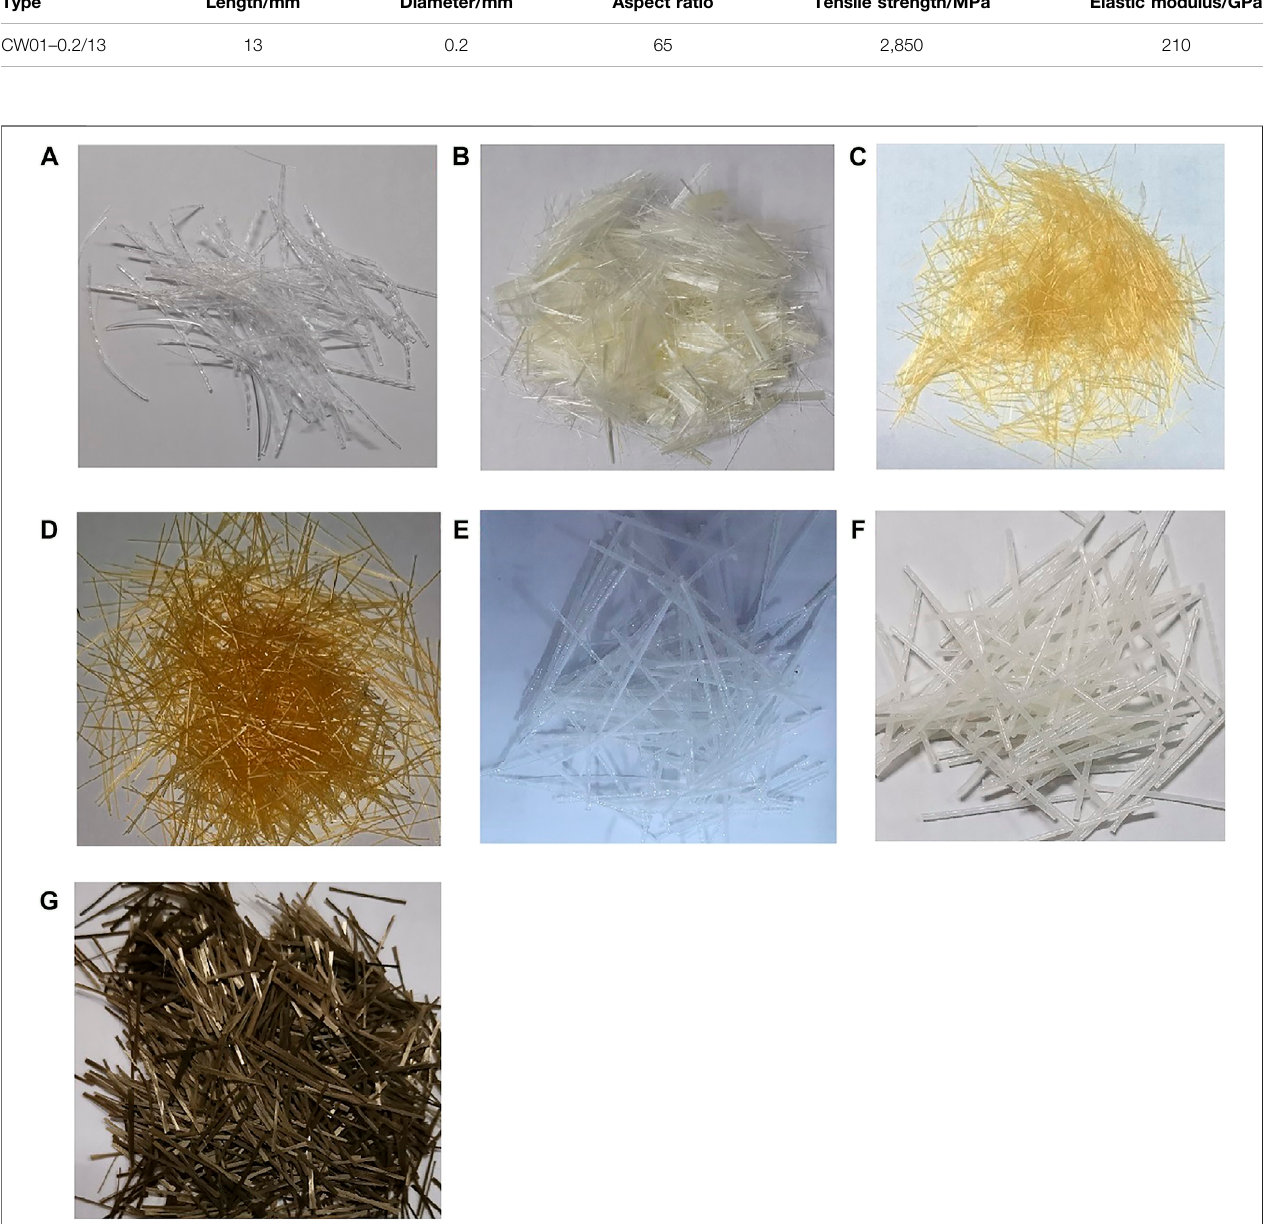
FIGURE1| Photosofnon-metallic fi bers. (A) PP-40-0.6, (B) PVA-12-0.04, (C) PVA-8-0.2, (D) PVA-12-0.2, (E) PET-30-0.75, (F) PET-30-0.9,and (G) BF-12-0.02.